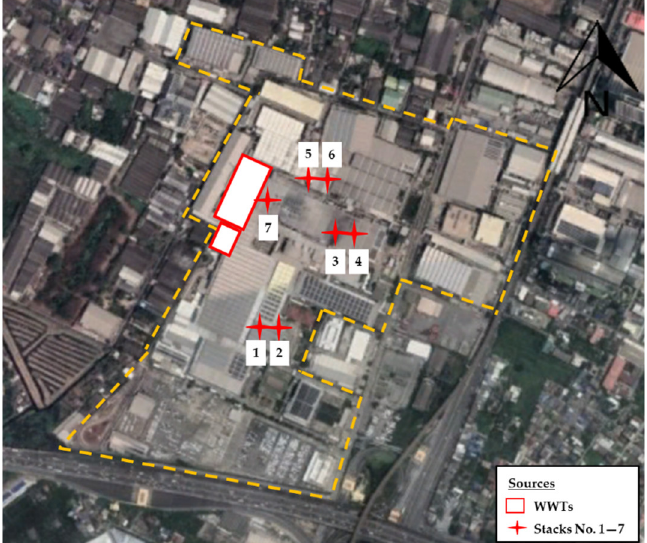
Figure 2. Scope and planned view sampling location of the factory.